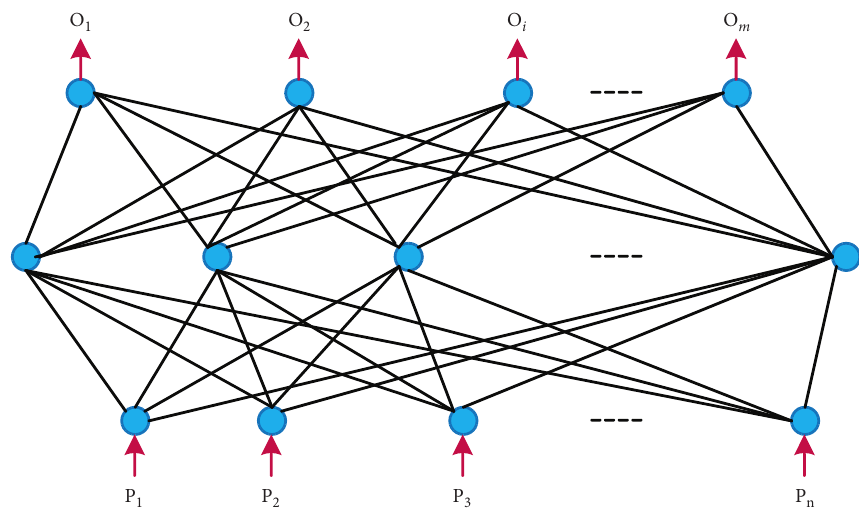
Figure 1: BP neural network model